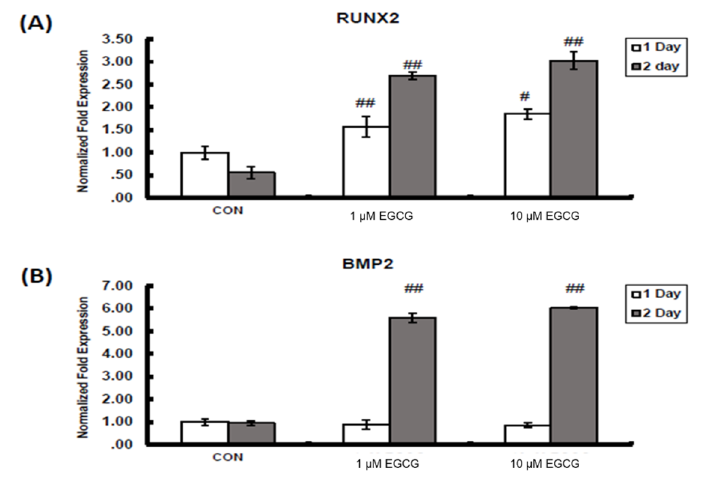
Figure 2. Cont. Molecules 2018 , 23 , x FOR PEER REVIEW